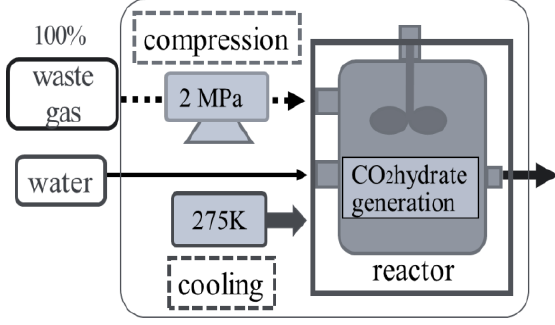
Figure 7. CO 2 hydrate